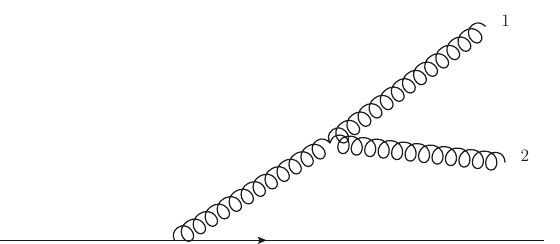
Figure 1. A diagram showing a quark emitting a gluon, which then decays to a pair of gluons. Using our simplified groomer, the two gluons are always clustered together first, the resulting branch is then clustered with the